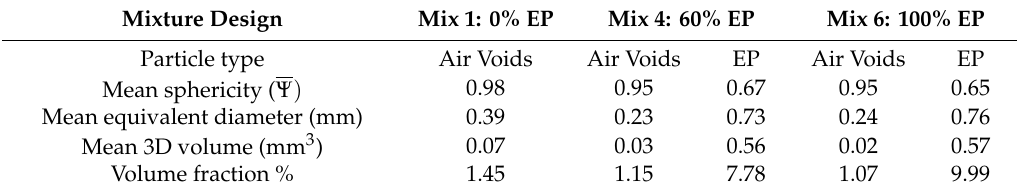
Figure 9. Cross-sectional CT image of block 7. ( Top ) Raw CT image scan. ( Bottom ) Thresholding applied to facilitate discrimination between paste particles and air voids / EP particles. applied to facilitate discrimination between paste particles and air voids/EP particles. Table 2. Size distribution and shape quantification of mixtures 1, 4, and Table 2. Size distribution and shape quantification of mixtures 1, 4, and 6